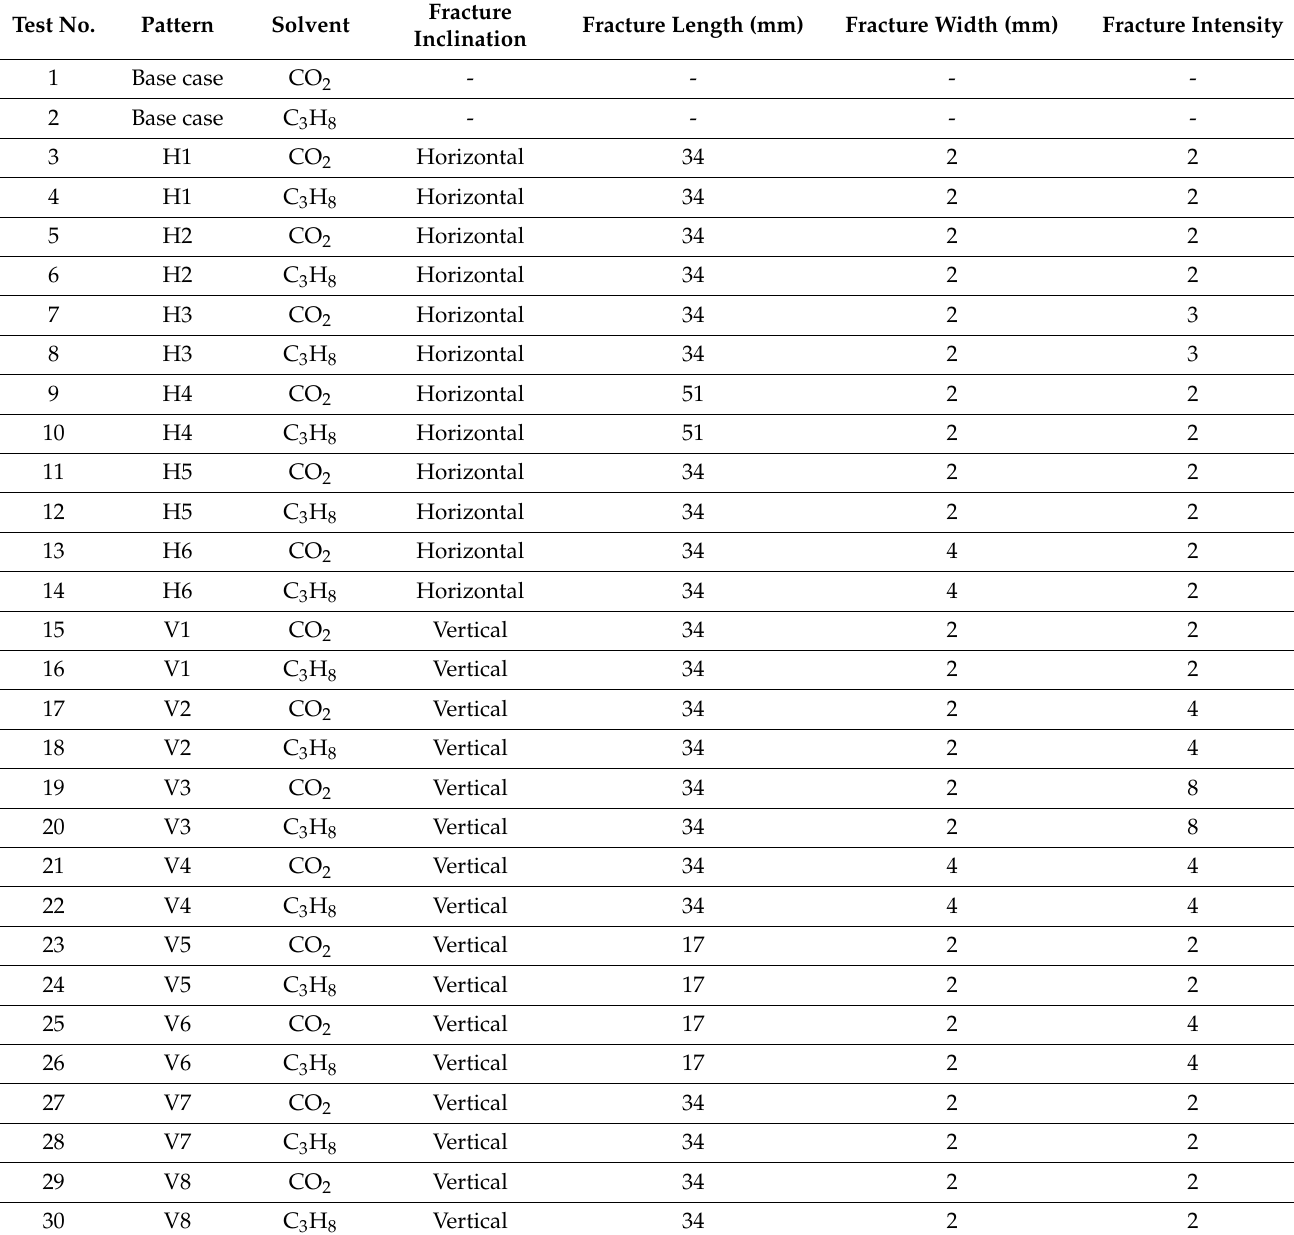
Table 2. The designed VAPEX tests in the fractured